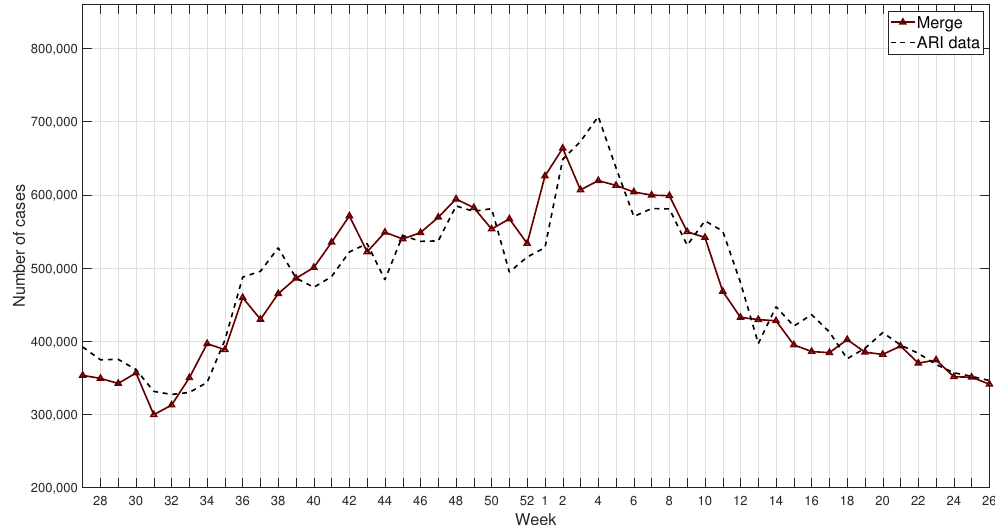
Figure 11. Example of results for the merge prediction for the 2017–2018 winter season compared with ARI data.